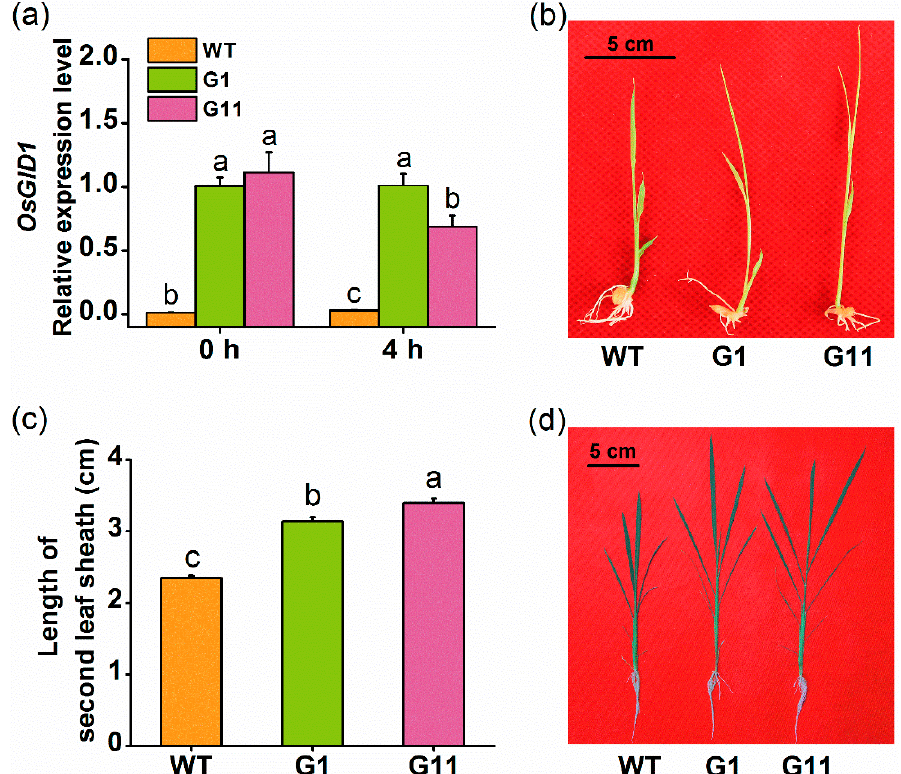
Figure 2. Relative expression levels of OsGID1 in wild type (WT) plants, and in plants from lines expressing OsGID1 and their growth phenotypes. ( a ) Relative levels (means + SE, n = 5) of OsGID1 transcripts in oe-GID1 and WT plants 0 and 4 h after they were wounded (these two experiments (two time points) were performed separately); ( b , d ) Growth phenotypes of oe-GID1 and WT plants at day 10 and day 38 in the greenhouse, bar = 5 cm; ( c ) Mean length (+ SE, n = 30) of the second leaf sheath of 10-day-old oe-GID1 and WT plants. Different letters indicate significant differences between oe-GID1 lines and WT plants (Duncan’s multiple range test, p < 0.05).